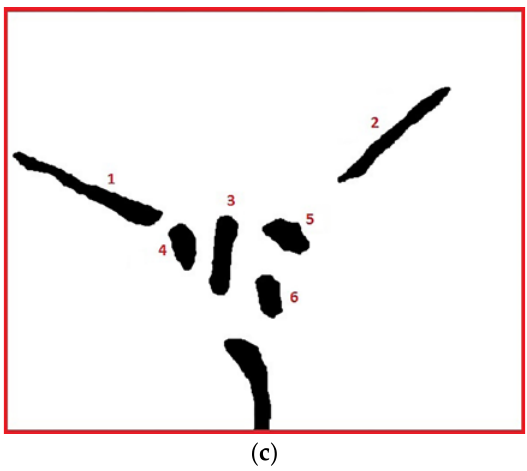
Figure 1. SEM image used for the measurement of indices: ( a ) low magnification image; ( b ) high magnification isolation of the group of particles; ( c ) image J display used for the measurement of indices. Table 4. Respective measurements for each particle referring to Figure 1c. Indices AR , C , and F correspond to the aspect ratio, circularity, and feret of the measured particles respectively. Accordingly, d max and d min are the major and minor diameters, p is the perimeter and A is the area of particles (refer to Table 3).